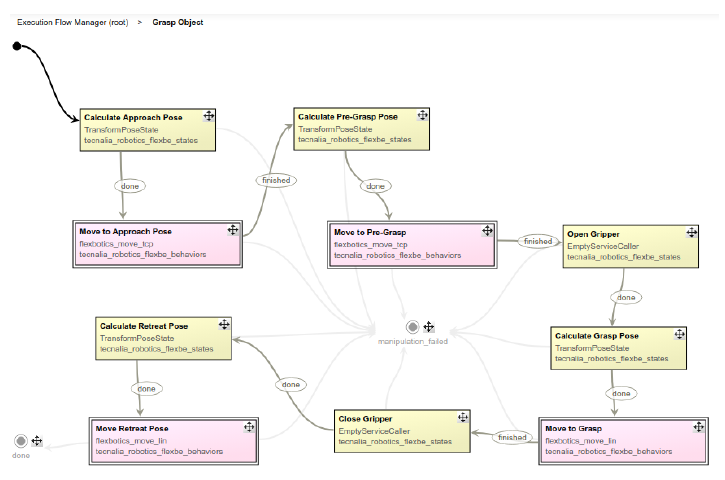
Figure 9. Grasp skill is composed of sequential robot movements and gripper